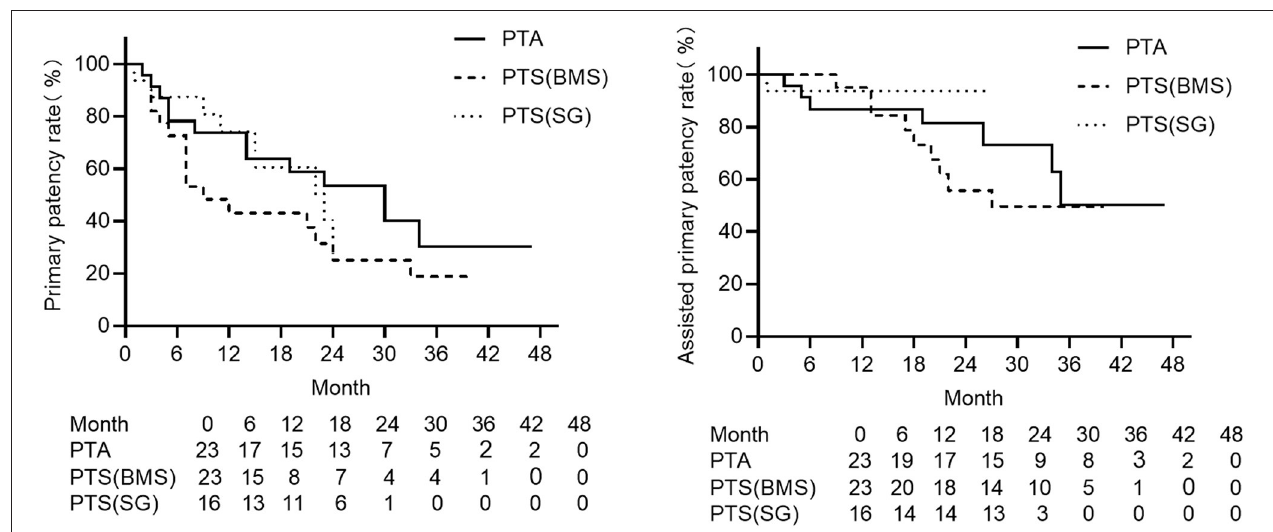
Frontiers in Neurology |